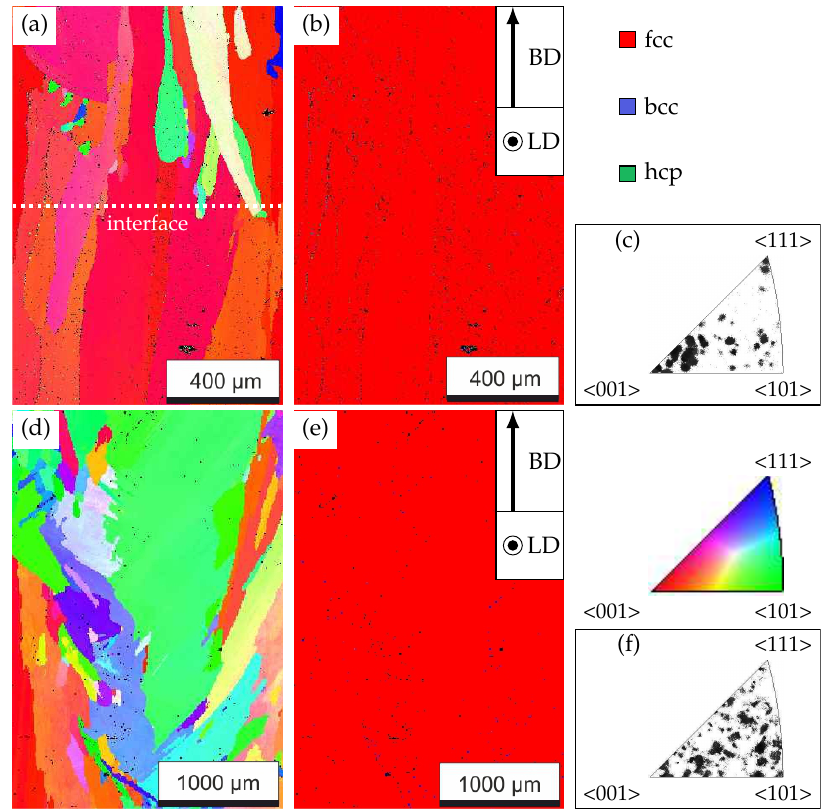
Figure 7. Inverse pole figure mappings (IPFM), phase mappings (PM) and inverse pole figures (IPF) of ( a – c ) sharp and ( d – f ) smooth transition regions. Grain orientations plotted with respect to